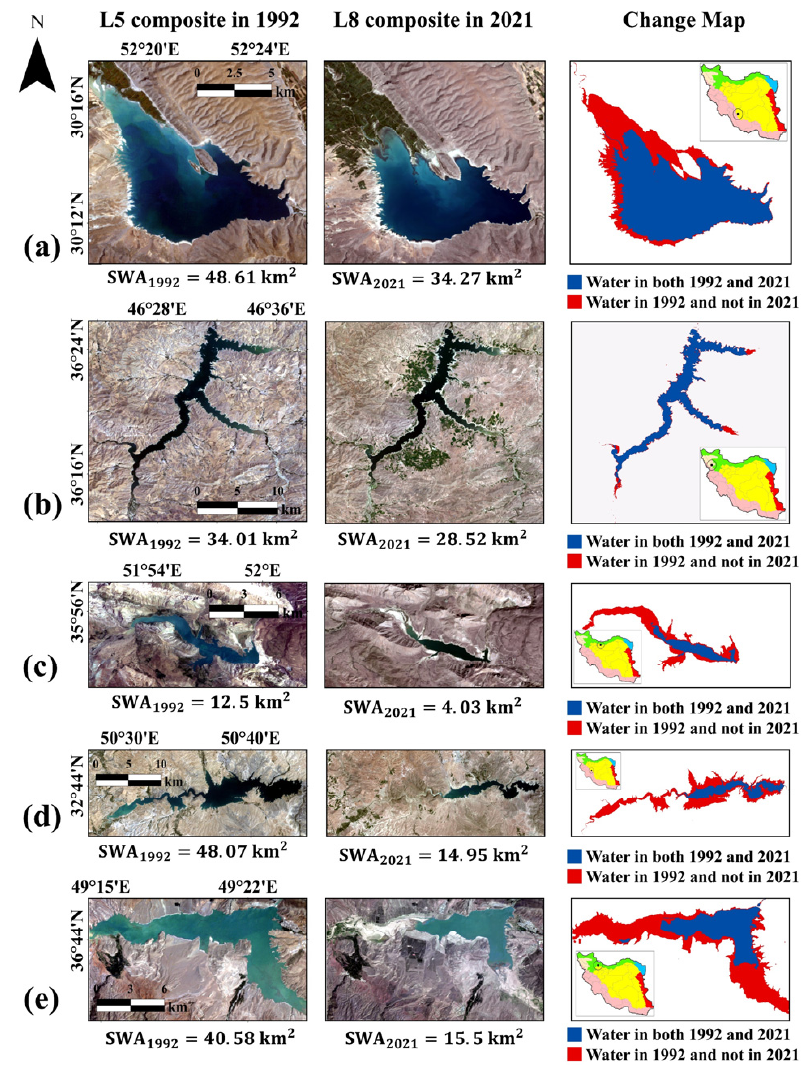
Figure 9. SWA changes between 1992 (wettest year in Iran (Figure 6)) and 2021 (latest status) for the ( a ) Doroudzan, ( b ) Kazemi, ( c ) Latyan, ( d ) Zayanderud, and ( e ) Sefidrud